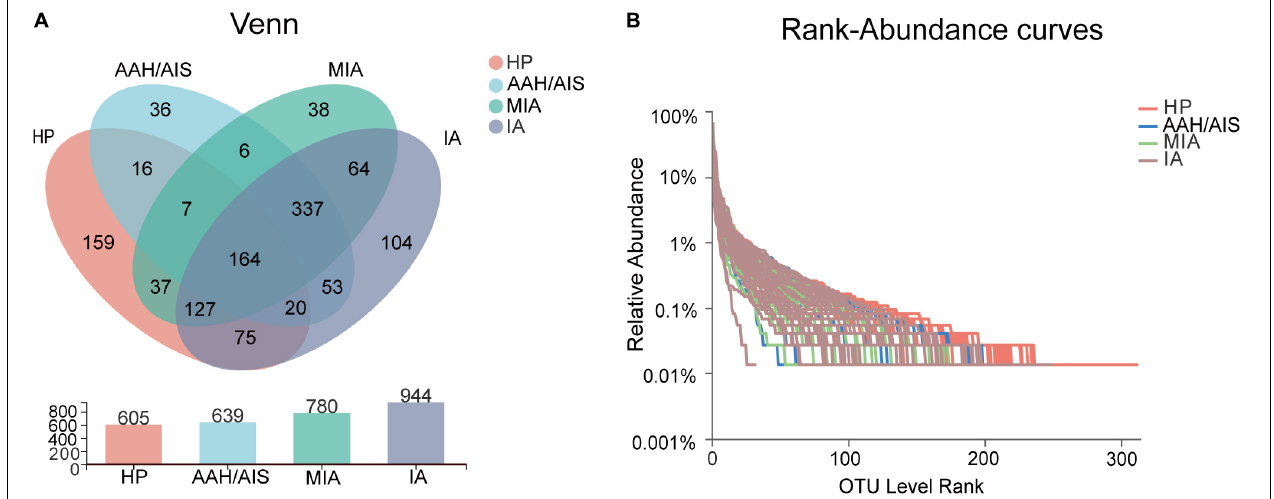
FIGURE 1 | Taxonomic analysis of 16S rRNA sequence data. (A) Venn diagram of OTU shared among the four groups. (B) Rank-Abundance curves of intestinal flora in four groups of samples.